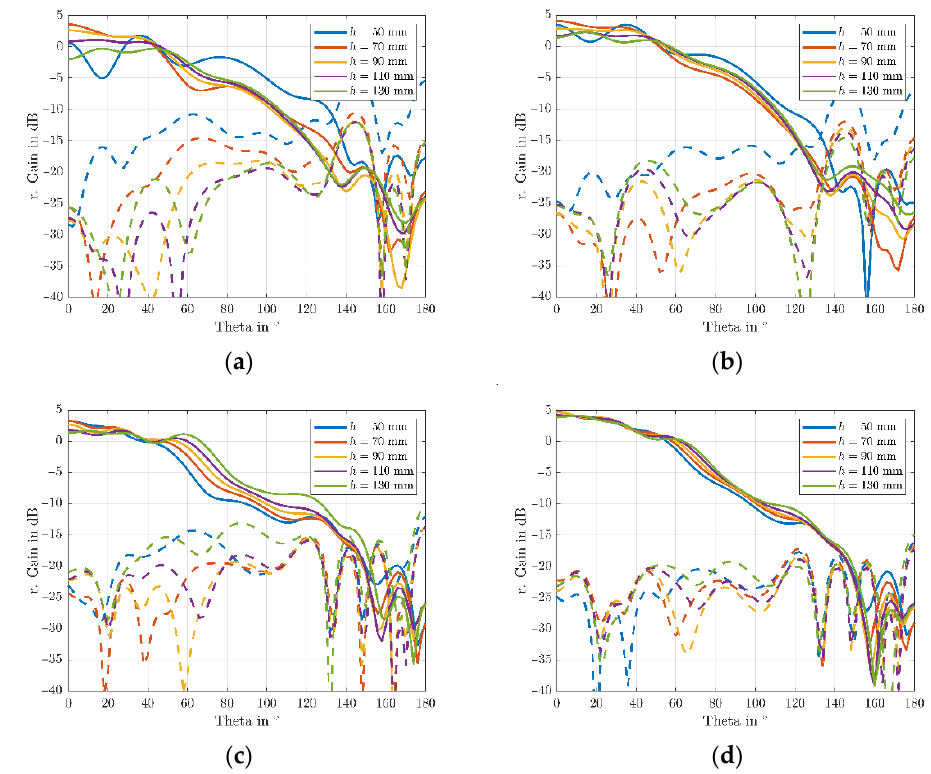
Figure 9. Simulated RHCP and LHCP realized gain patterns of the miniaturized GNSS array with and without vertical choke rings on a hex-rotor UAV for different installation heights. ( a ) L5/E5a without vertical choke; ( b ) L5/E5a with vertical choke; ( c ) L1/E1 without vertical choke; ( d ) L1/E1 with vertical choke.